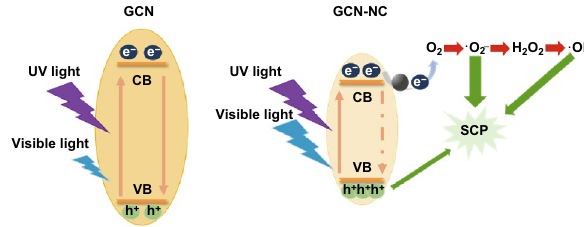
Fig. 9 Mechanism scheme of GCN-NC in photocatalytic degradation of